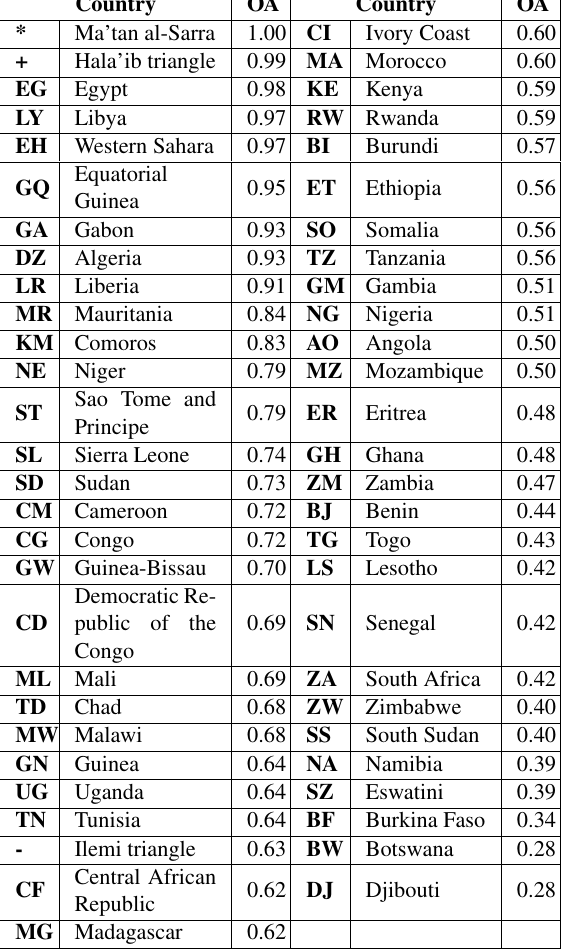
Table 4. OA for African countries Table 4 is summarized in the Table 5 using statistics like min- imum, maximum, median, mean, weighted mean and standard deviation. It also contains the value of OA for whole African con- tinent as it is mean of OA scores for individual countries weighted by the proportion of their areas in the total area of the continent. Table 6. Summary statistics for PA (Class labels corresponding In addition, standard deviation weighted by a country area was to the class code from the header can be seen in Table 2) computed and included in the table of summary statistics. Likewise, for PA, summary statistics were computed also for UA Furthermore, OA for different countries were shown by the map (Table 7). Again, UA Africa (UA weighted mean), mean, me- dian, standard deviation and weighted standard deviation are (Figure 1) to depict spatial distribution of OA .